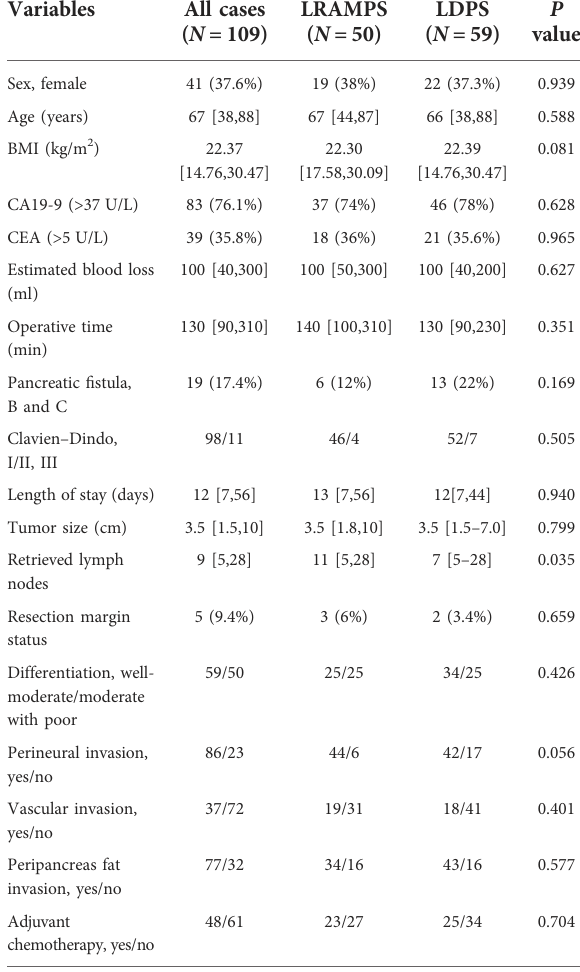
TABLE 1 Clinicopathological characteristics of patients with left-side pancreatic ductal adenocarcinoma.